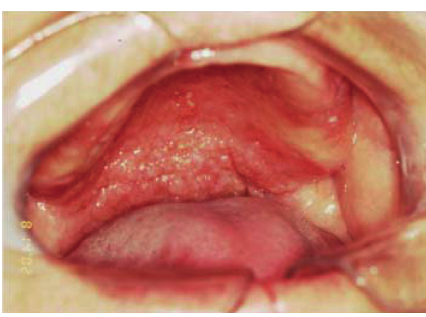
Figure 3: Granulomatous lesion on the palate.